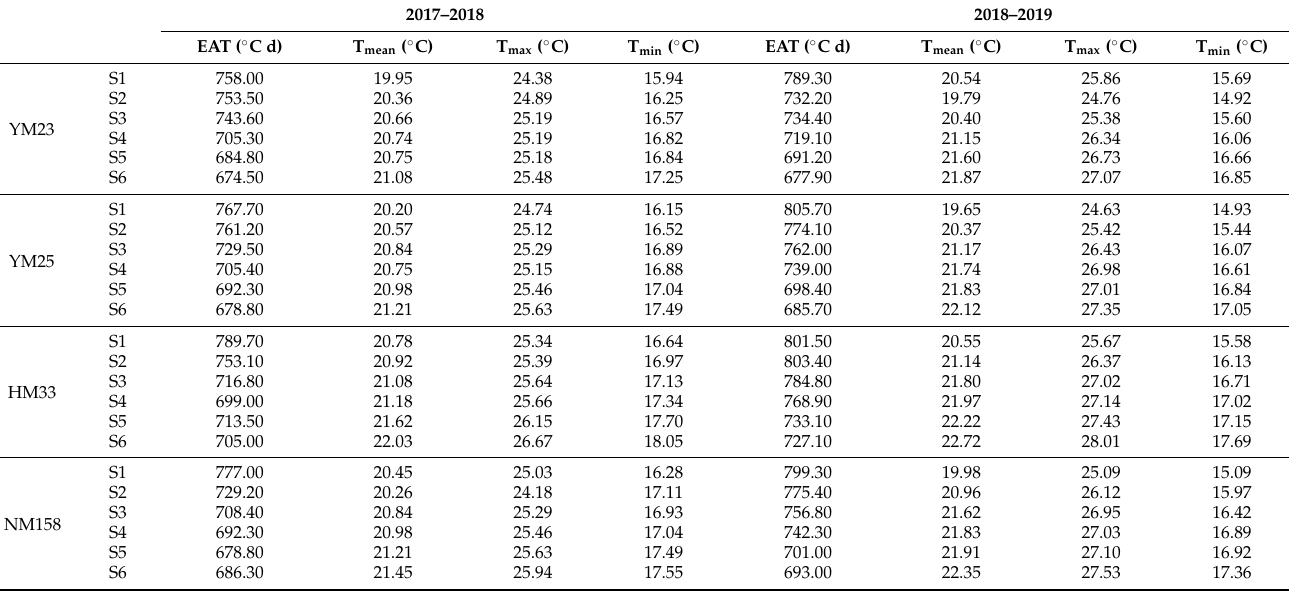
Table 1. Effects of different treatments on post-anthesis temperature.